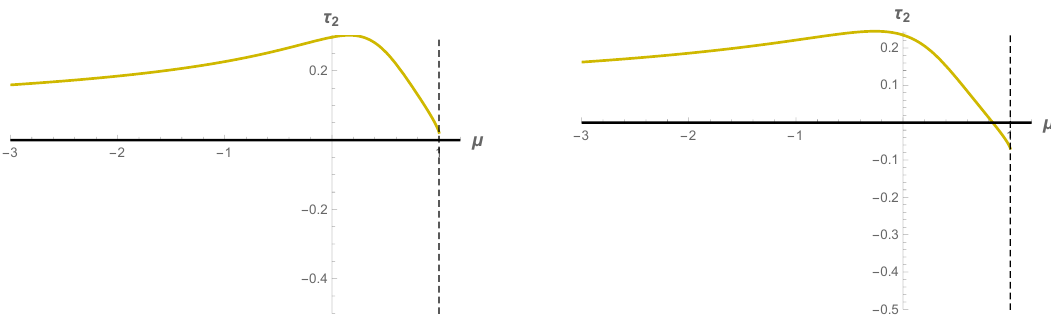
Figure 10 . Plots of the function τ 2 ( µ ) in the [H1,E2] or [H1,E2 0 ] branch of solutions for ‘ 2 /‘ 1 = 1 . 5 . The critical tension is λ 1 . 12 . The curve on the left is for λ 0 ‘ 2 ≈ right for λ = 1 . 35 0 ‘ 2